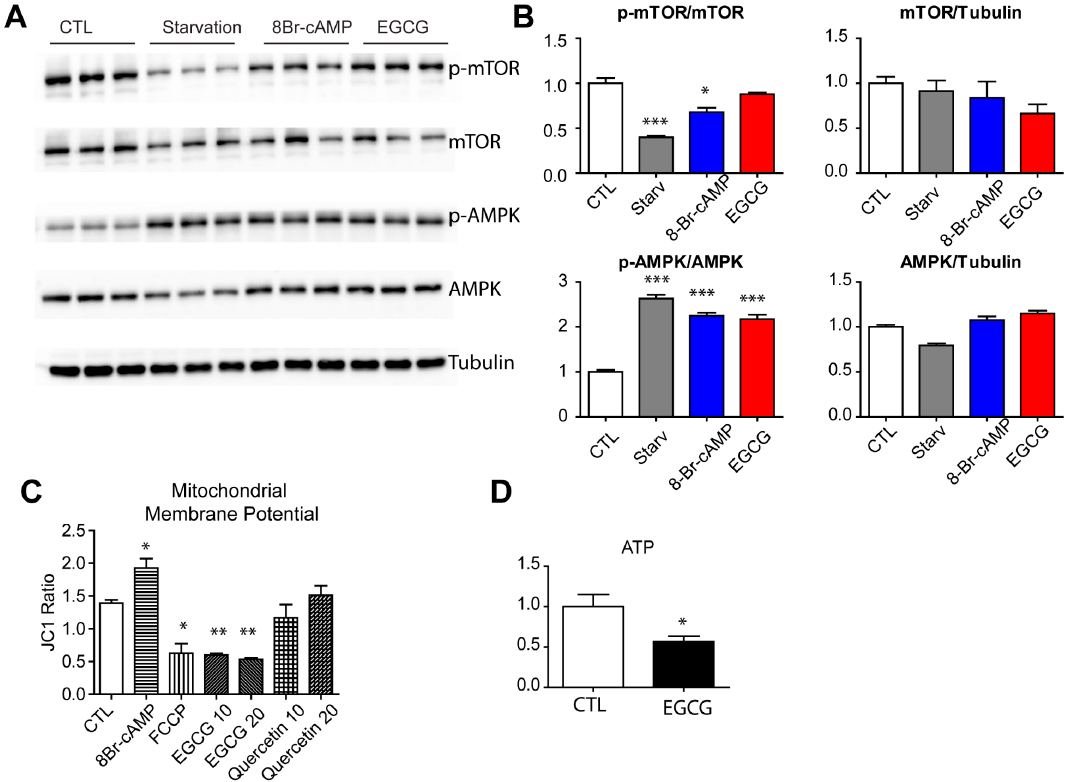
Figure 5. Effects of EGCG on activation of mTOR and AMPK in adipocytes. ( A , B ) Immunoblot analysis of phosphorylation of mTOR and AMPK in adipocytes differentiated from C 3 H 10 T1/2 treated with starvation medium, 8Br-cAMP (1 mM) and EGCG (10 µ M) for 24 h. Mitochondrial membrane potential ( C ), and intracellular ATP ( D ) in adipocytes differentiated from C 3 H 10 T1/2 treated with 8Br-cAMP (1 mM), FCCP (0.5 µ M), EGCG (10 or 20 µ M) or quercetin (10 or 20 µ M) for 2 h. p values were calculated using the two-tailed unpaired t -test ( n = 3, means ± SE; * p < 0.05, ** p < 0.01, *** p < 0.001).